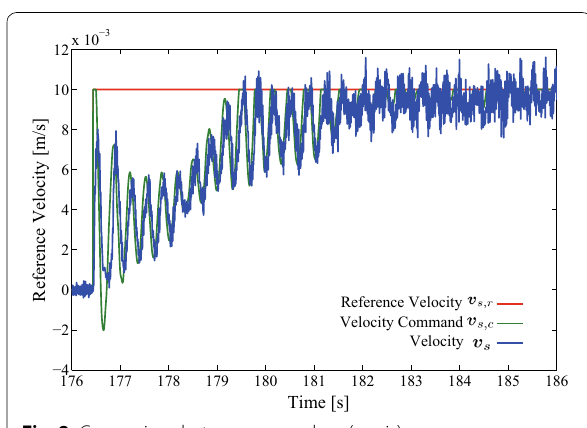
Fig. 8 Comparison between v s , c and v s , r (x-axis)